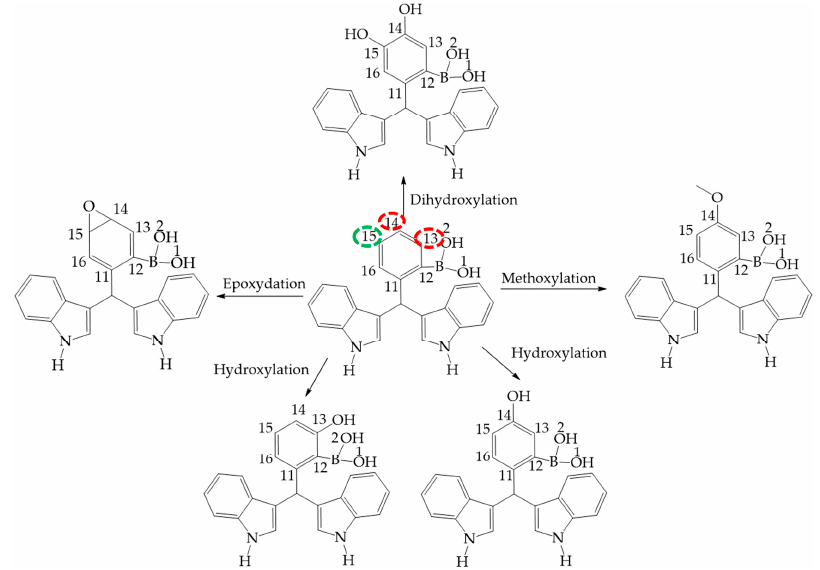
Figure 11. Phase 1 metabolic pathway of I . The red color indicates high values of NOR, from 0.66 to 1. The green color indicates a NOR value range of 0.15 to 0.33. A high NOR indicates a more frequently reported site or metabolism in the metabolite database. The red color indicates high values of NOR, from 0.66 to 1; the orange color designates values between 0.33 to 0.66, the green color indicates a NOR value range of 0.15 to 0.33, the white color, range values of 0.00 to 0.15 and finally grey denotes lack of data. It is important to highlight that in the studied molecules only red and green colors were found. Moreover, the number of metabolites